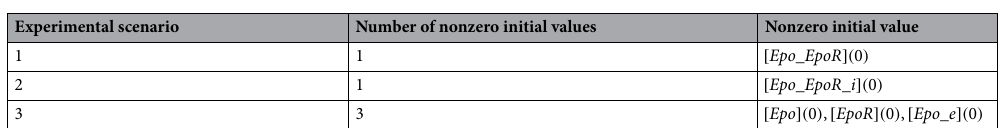
Table 1. List of plausible nonzero initial value combinations that ensure the structural identifiability of the Erythropoietin (Epo) and Epo receptor (EpoR) model ( M 3 ).